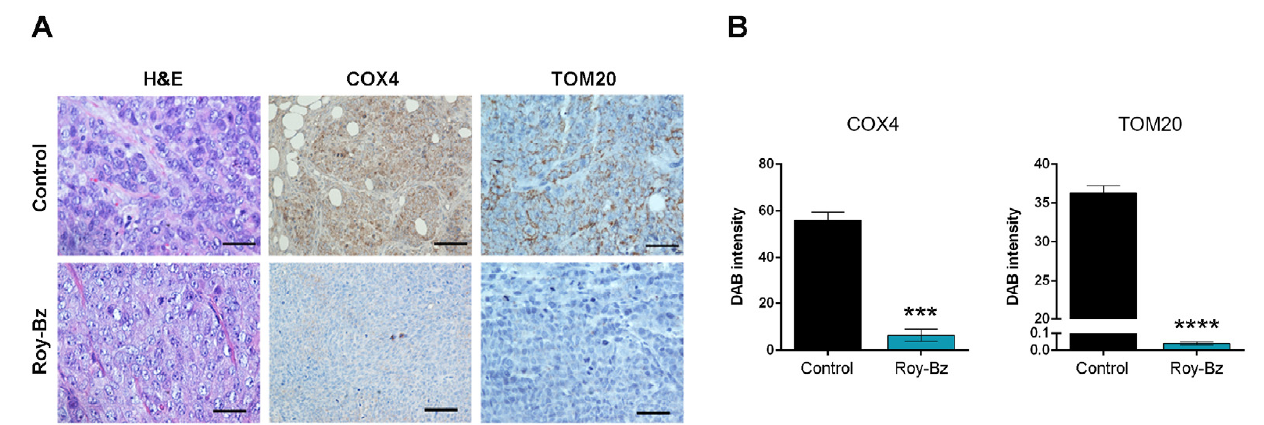
Figure 4. Roy-Bz inhibits cellular respiration in tumor tissues of human colon xenograft mouse models. ( A ) Representative images of IHC of mitochondrial markers (COX4 and TOM20) detected in tumor tissues of HCT116 xenografts treated with 10 mg/kg Roy-Bz or vehicle (control) and collected at the end of the treatment (scale bar =5 µ m; magnification = × 200; hematoxylin and eosin (H&E)). ( B ) Quantification of IHC staining of HCT116 xenograft tumor tissues was assessed by evaluation of DAB intensity. Data are mean ± SEM; values significantly different from control (*** p < 0.001, **** p < 0.0001), unpaired Student’s t -test.